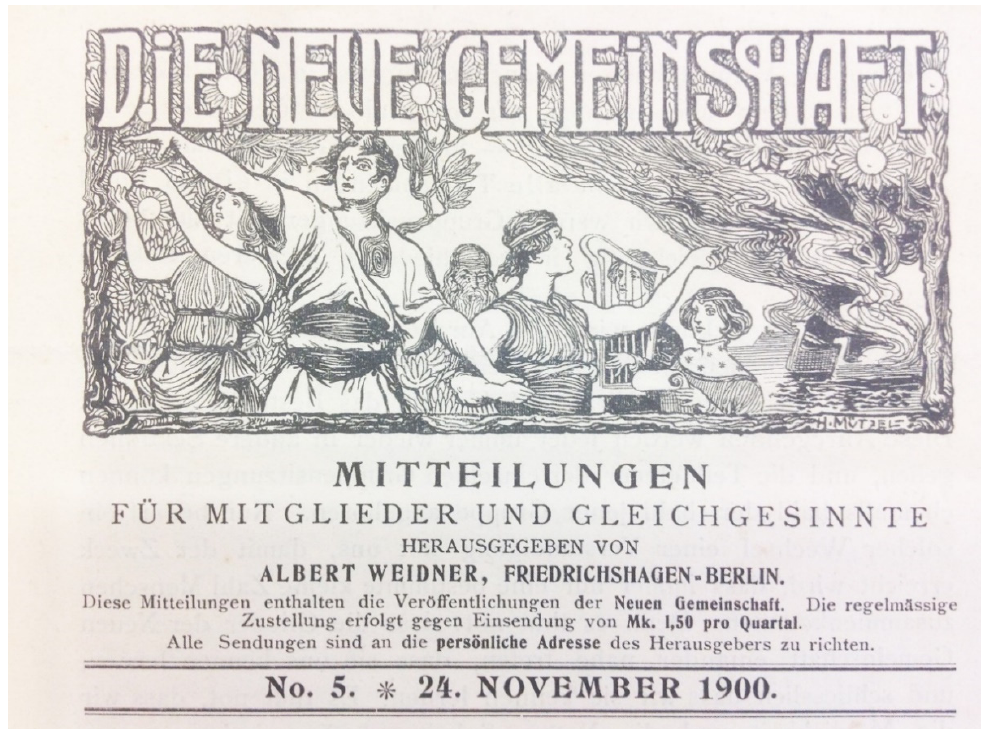
Figure 1. Front material of one of the group’s pamphlets. Courtesy of the Stadt- und Landesbibliothek Dortmund (StLB Dortmund, JHN Nr. 2809).